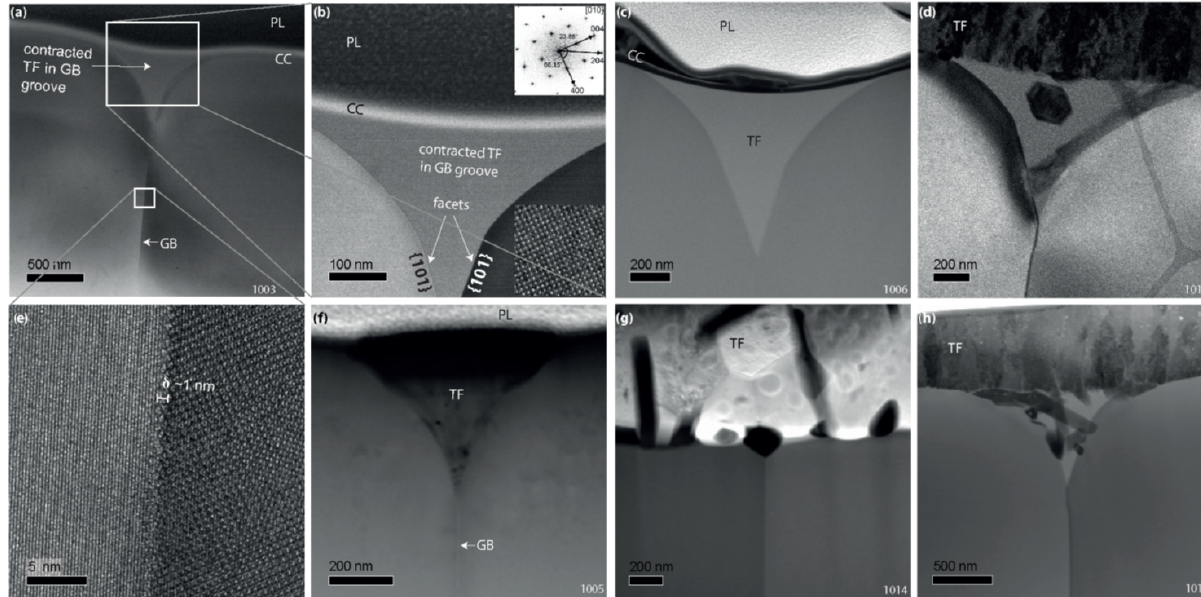
Figure 4. TEM micrographs taken after the experiments. TF: thin film, CC: carbon coating, and PL: platinum layer created by FIB prepa- ration. (a) BF micrograph of sample TH_9_2 (1003), which was annealed 24.1h at 1450 ◦ C. The originally 50nm thick film contracted into the grain boundary groove (middle) and is amorphous. (b) BF micrograph corresponding to the upper rectangle of (a) with the right grain oriented along the [010] zone axis. The FFT is calculated from the inserted HRTEM of the right crystal. (c) HAADF micrograph of sample TH_9_3 (1006) annealed 24.0h at 1450 ◦ C. The thin film contracted into the grain boundary groove (middle) and is